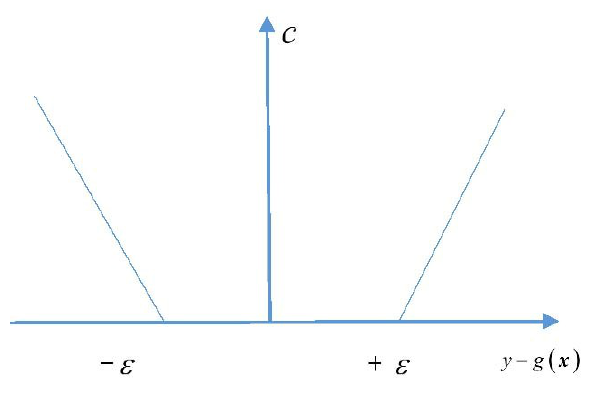
Figure 1. Structure of the SVR.